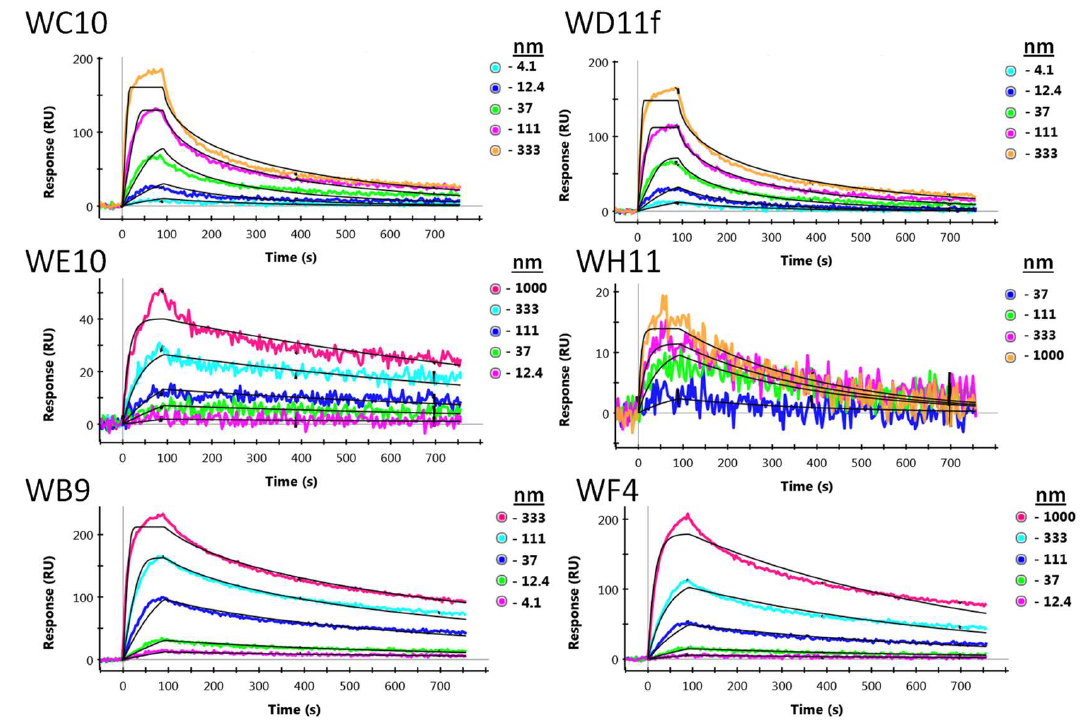
Figure A2. Representative surface plasmon resonance data.